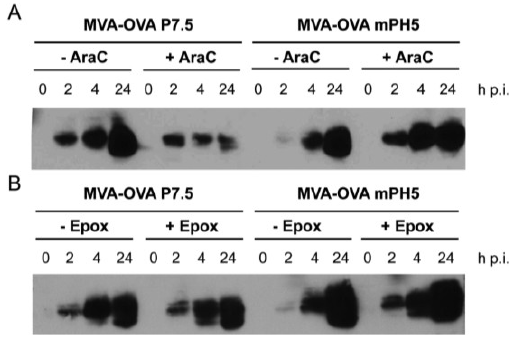
Figure 1. Expression under control of mPH5 results in degradation of gene products at early time points. Human A375 cells were infected with either MVA-OVA P7.5 or MVA-OVA mPH5 at MOI 10. Cells were harvested at the indicated time points (h p.i., hours post infection) and cell lysates were prepared. ( A ) Cytosine β- D -arabinofuranoside (AraC), inhibited intermediate and late gene expression; ( B ) Epoxomicin (Epox), inhibited intermediate and late gene expression and protein degradation by blocking the proteasome.